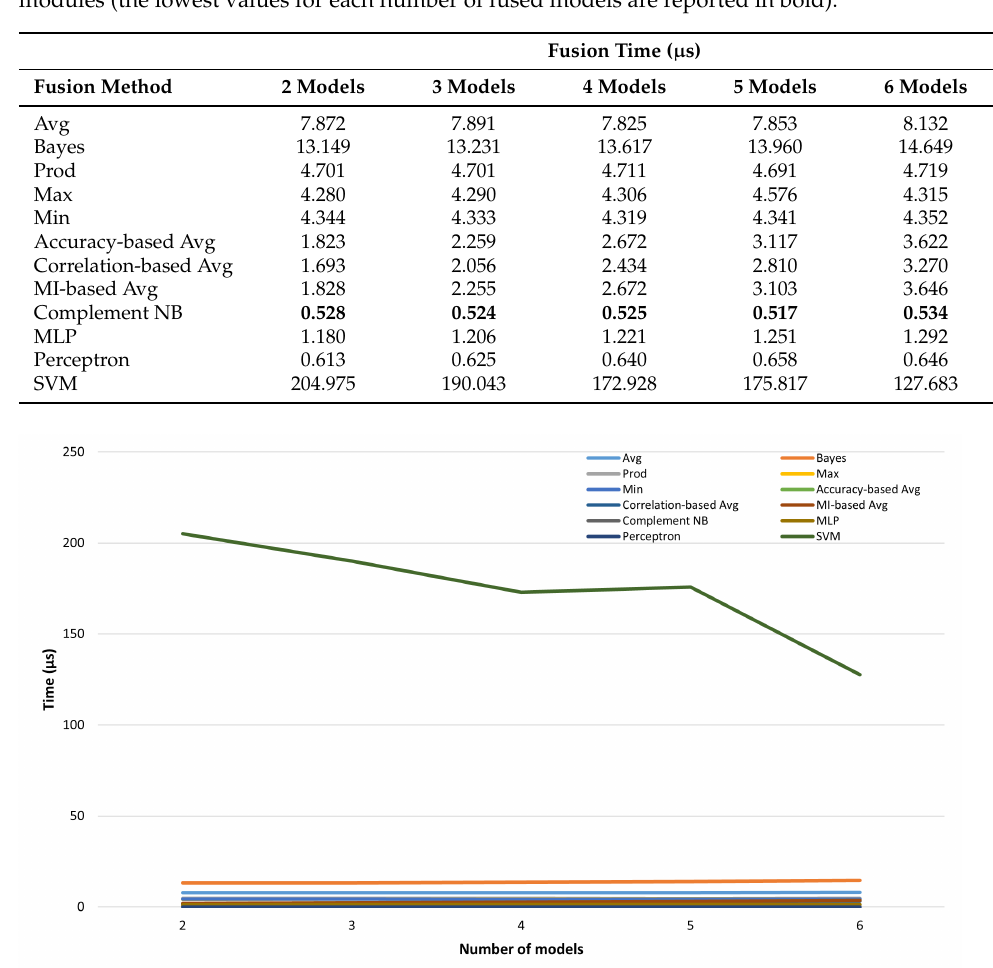
Figure 8. Inference time of fusion methods for various numbers of fused